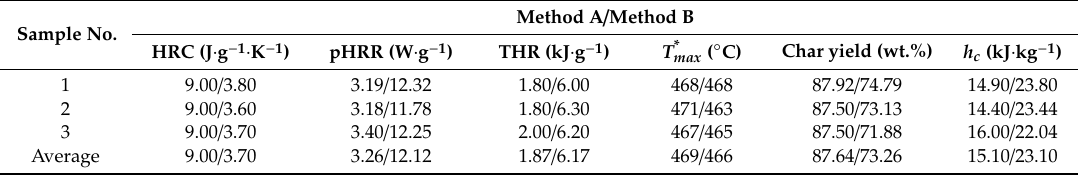
Table 6. PCFC parameters for the ONHM